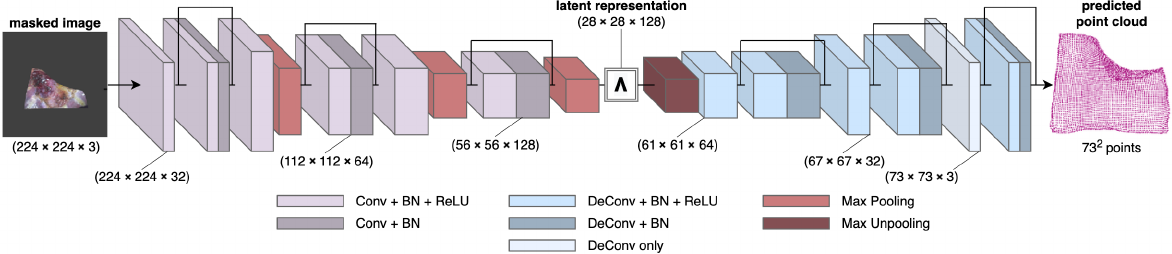
Figure 5. Overview of the HDM-Net [5] architecture. It has an encoder that takes an RGB image of size 224 × 224 × 3 and encodes it into a latent representation of size 28 × 28 × 128. This is then used by the decoder to reconstruct a 3D point cloud of the surface with 73 2